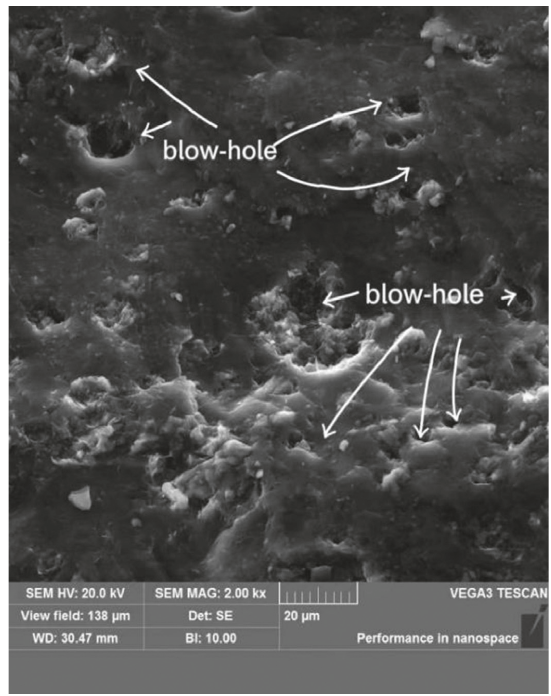
Figure 2: Relative concentration of